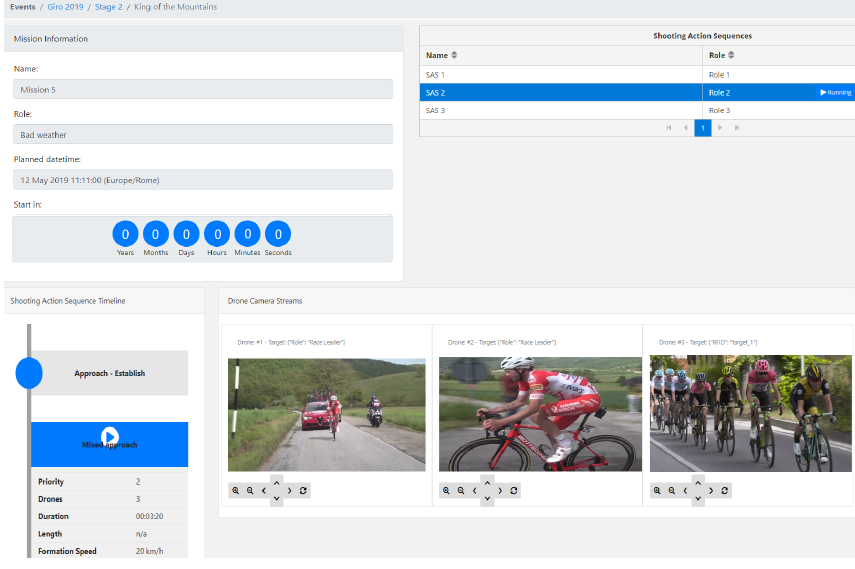
Figure 8. Example screenshot of the mission execution